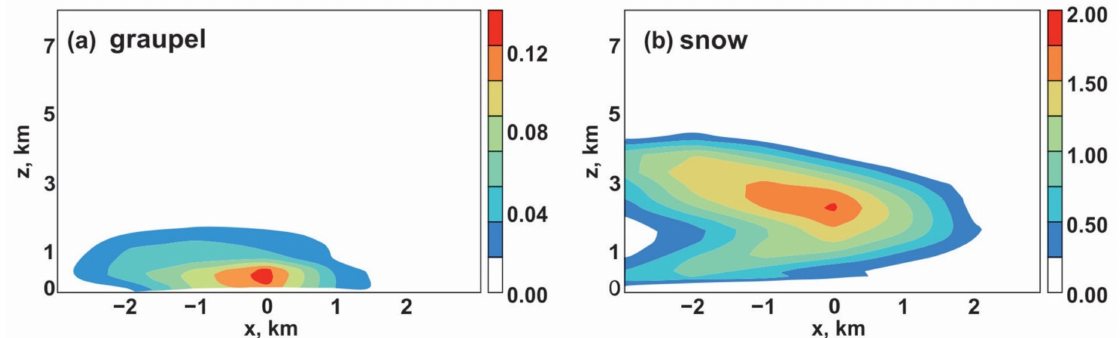
Figure 12. The spatial distribution of the graupel ( a ) and snow ( b ) particles modeled by WRF at 16:50 UT on 25 May 2018. The vertical axes started on Aragats station height (3200 m), x axes are oriented from west to east, and the coordinate origin (zero) corresponds to the location of the Aragats station. The coloring characterizes the density of hydrometeors in ng/cm 3